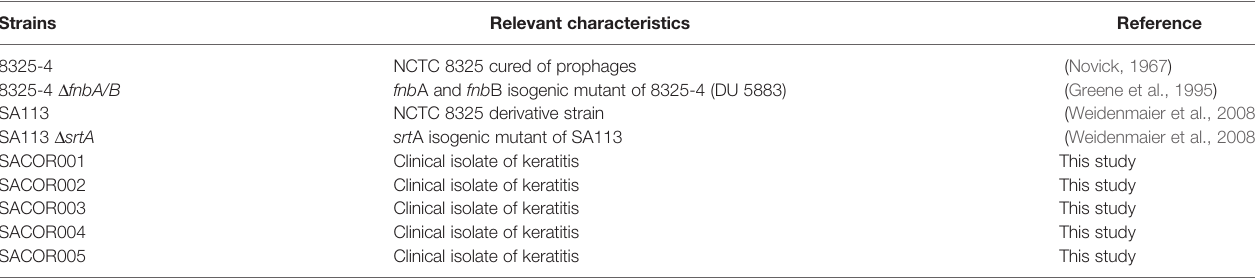
TABLE 1 | Bacterial strains used in this